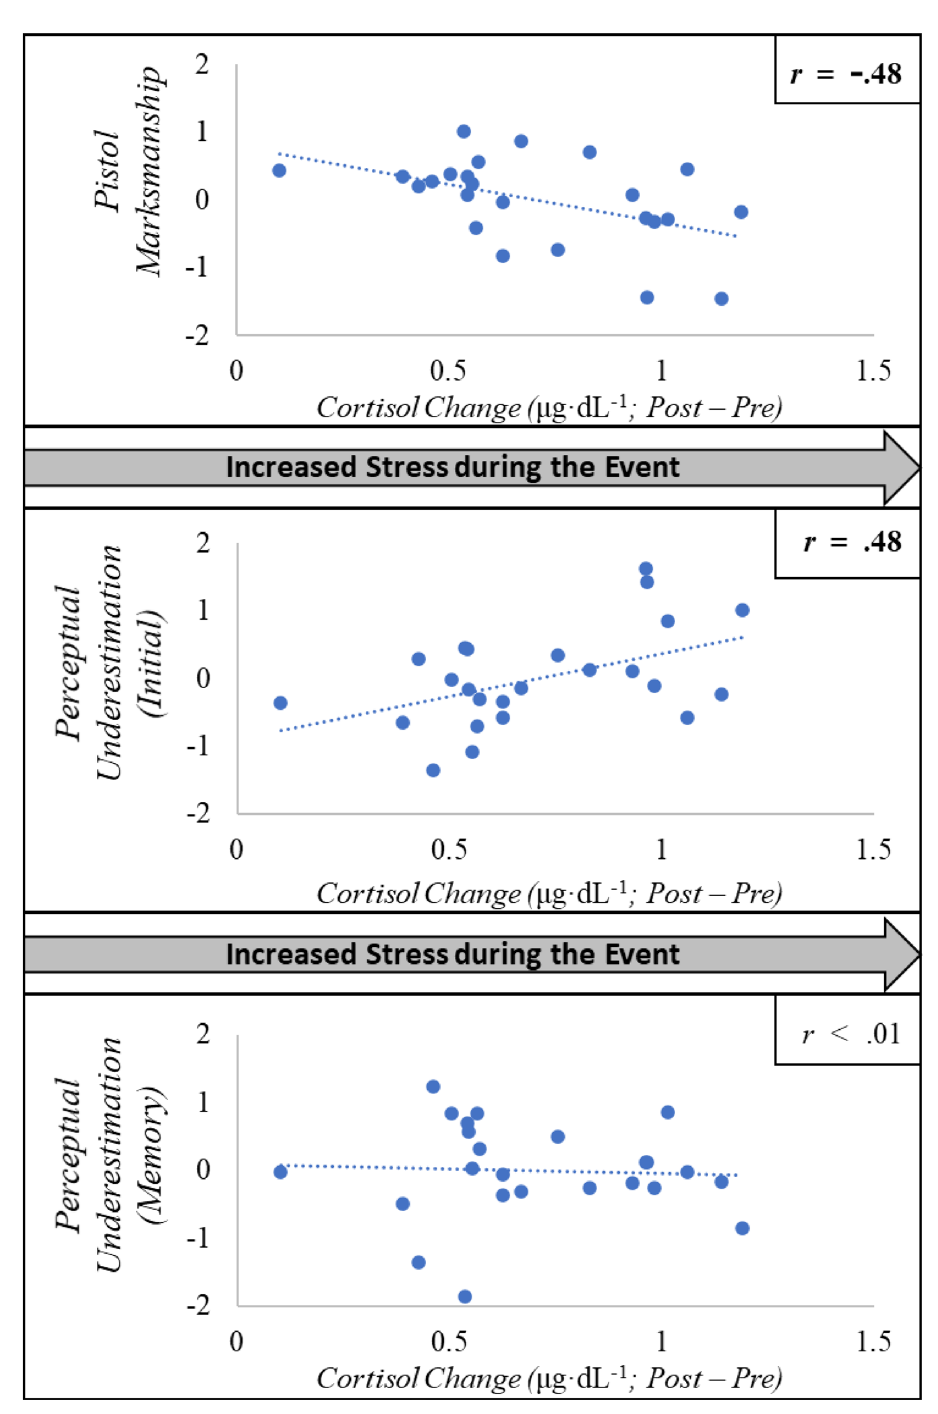
Figure 2. Scatterplots depicting the relationship between changes in stress level (as measured through salivary cortisol changes before versus after the stress-inoculation exercise) with average difference in z units for pistol marksmanship (top image), originally reported perceptual estimations across all three situational awareness variables (actual − original; middle image), and change as those estimations were consolidated into memory (original − memory; bottom